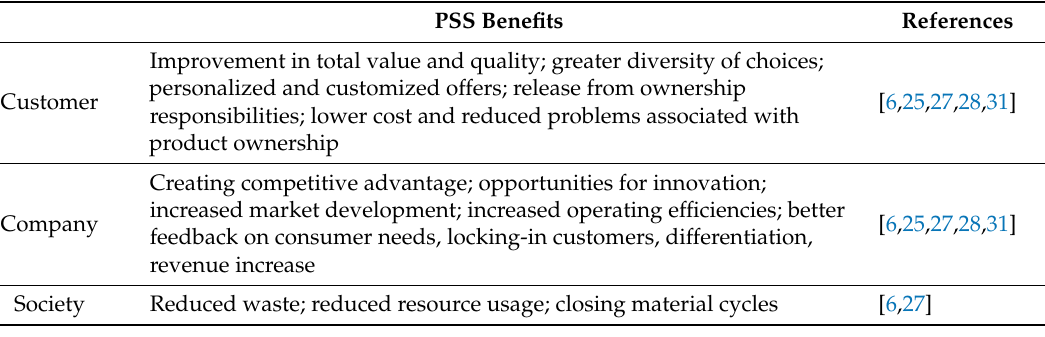
Table 1. Summary of PSS (Product-Service Systems) benefits.